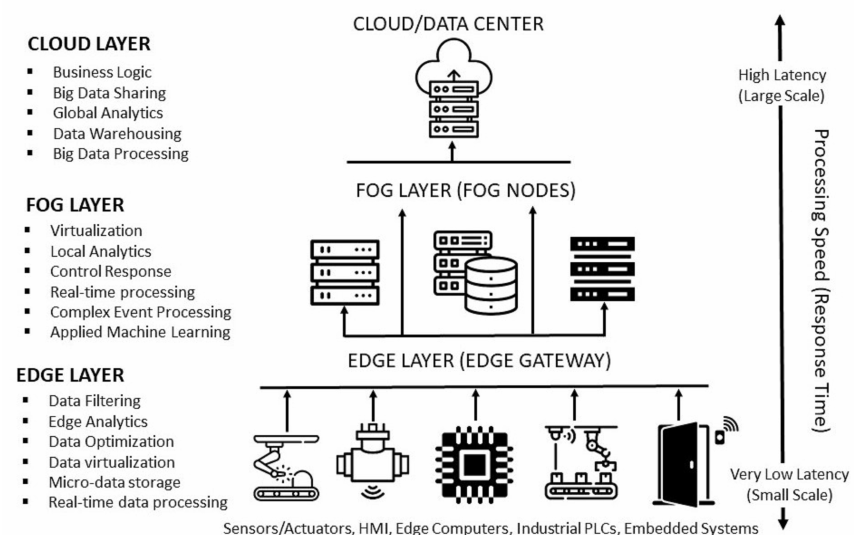
Figure 20. Cloud–fog–edge layer